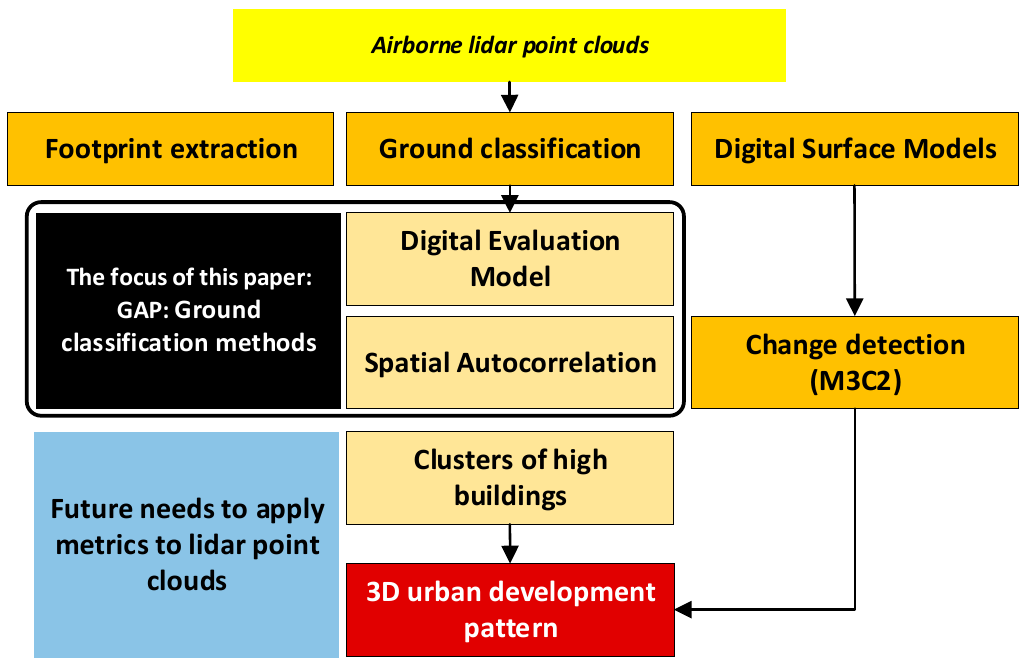
Figure 2. The procedure of spatial and temporal 3D urban development, and the focus of this paper on ground classification techniques.